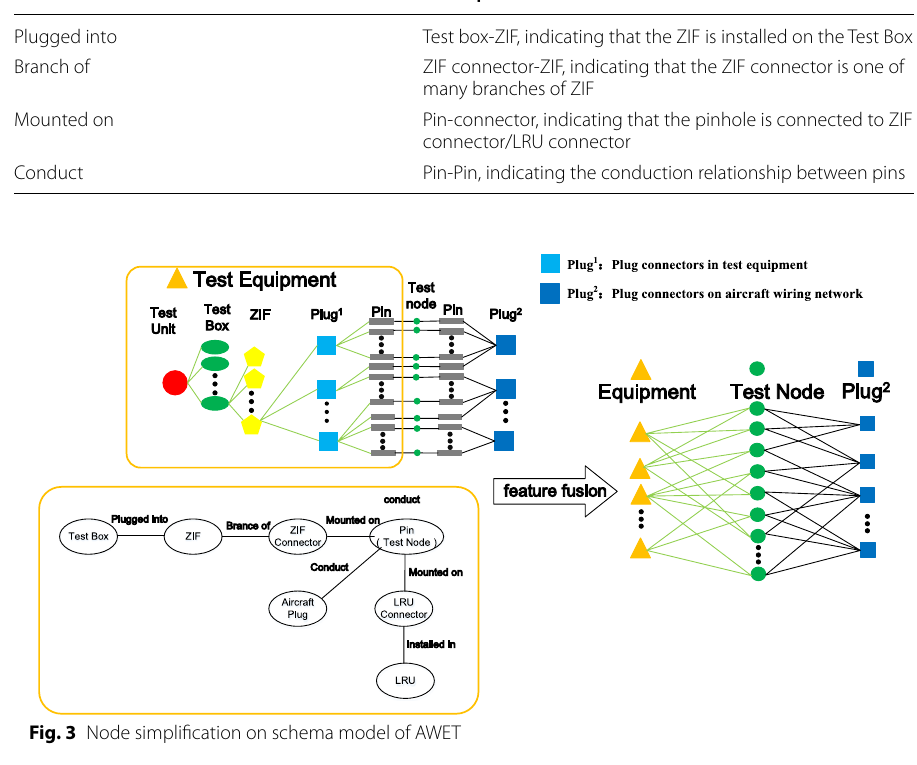
Fig. 3 Node simplification on schema model of